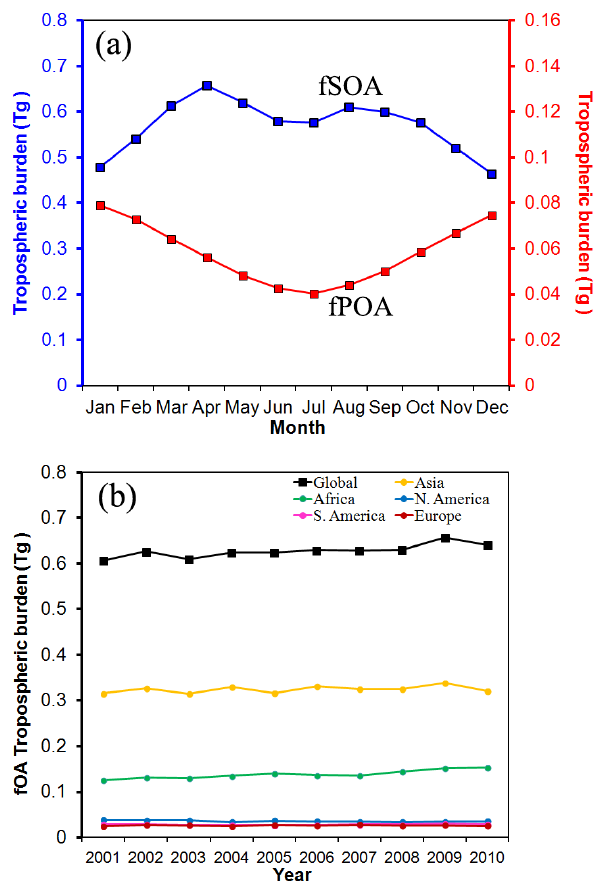
Figure 6. (a) Average predicted tropospheric burden (Tg) of fSOA (in blue, primary y axis) and fPOA (in red, secondary y axis) and (b) annually averaged tropospheric burden of total fuel combustion OA (fOA) during 2001–2010.